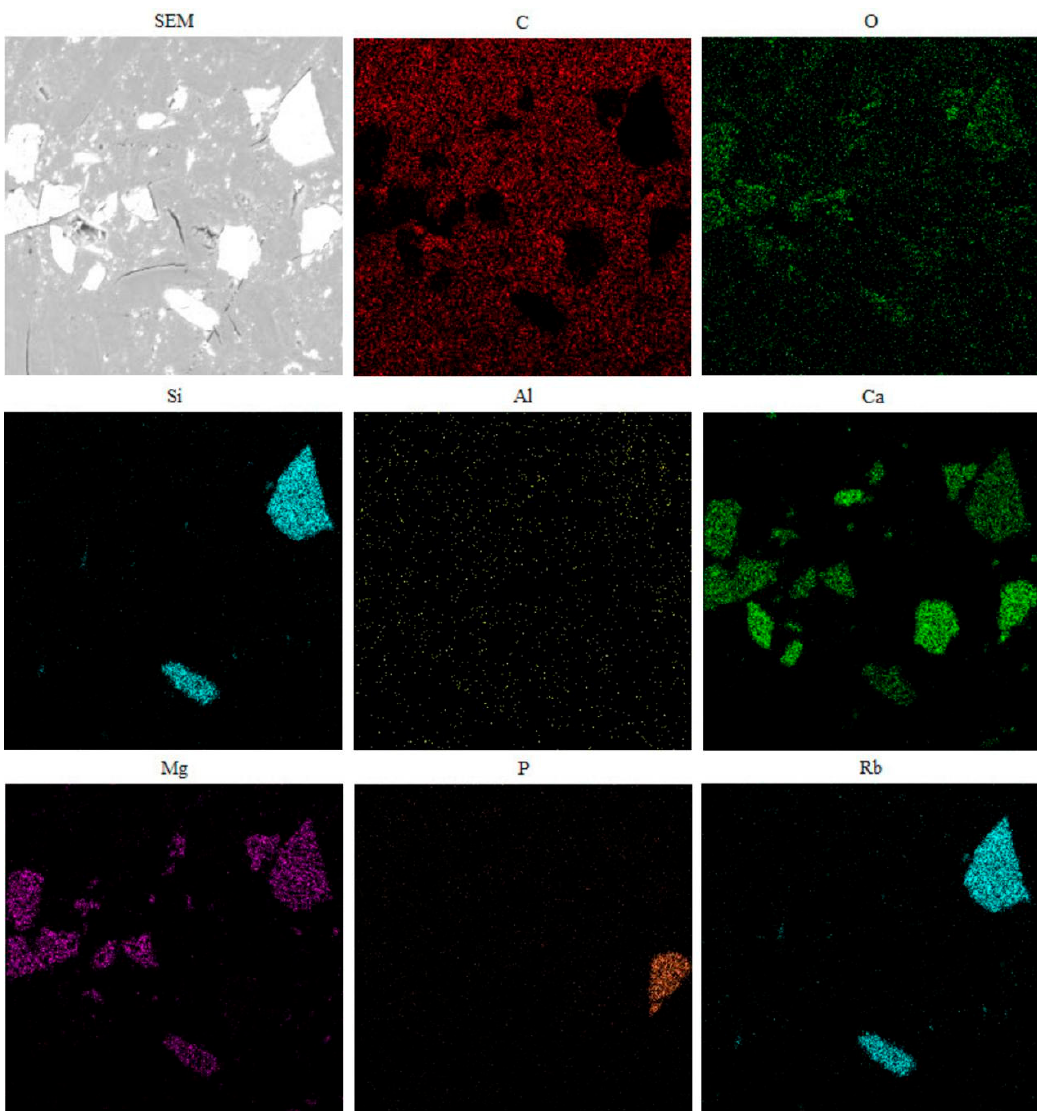
Figure 8. Areal distributions of C, O, Si, Al, Ca, Mg, P, and Rb in Figure 7b.